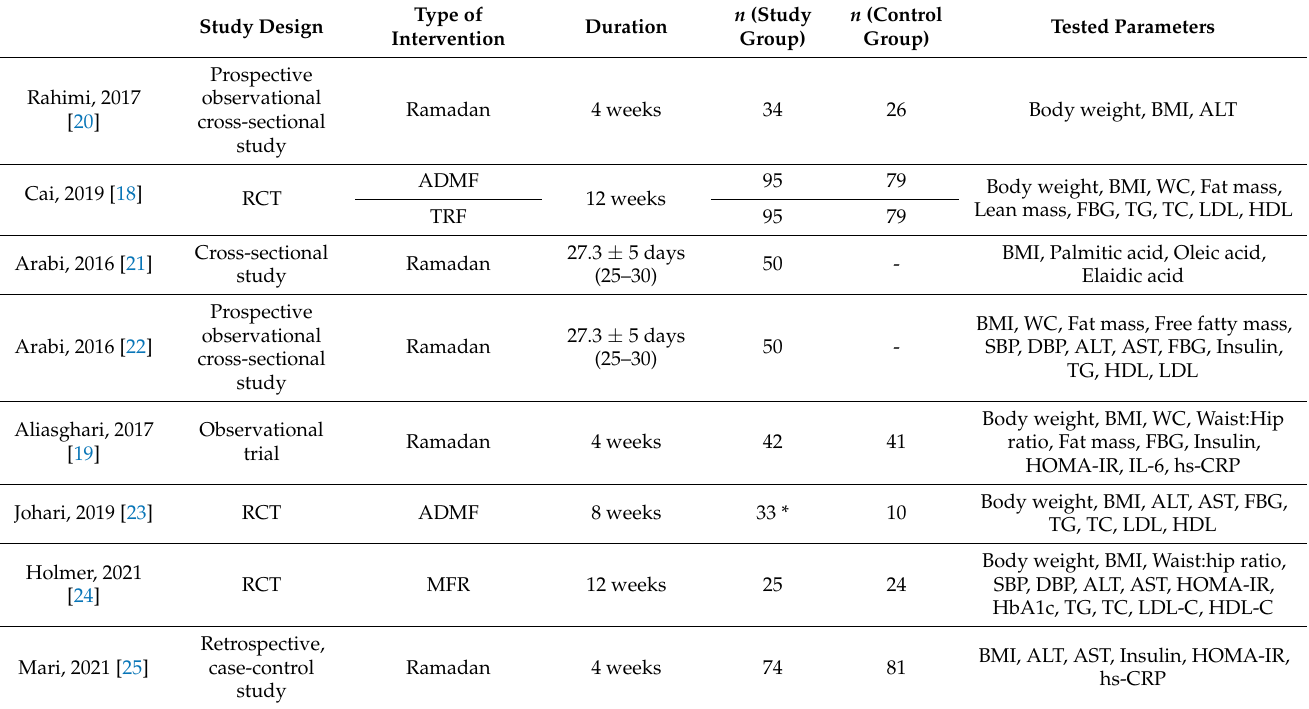
Table 3. Characteristics of included